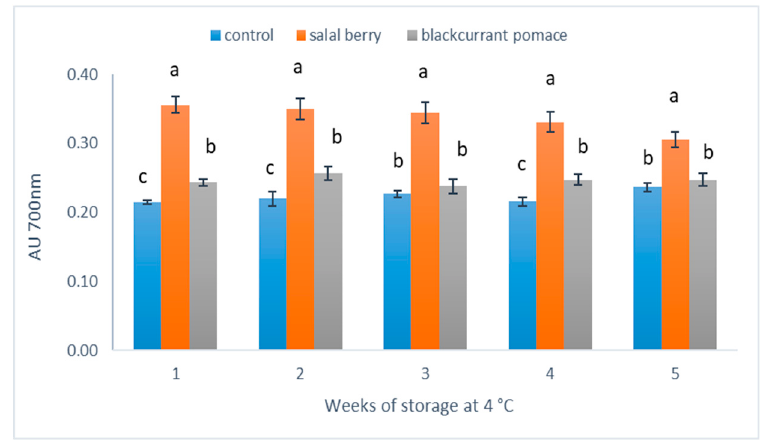
Figure 5. Reducing power of different yogurt beverages. Results are presented as means ± SD. Different low case letters denote significant differences at each time point ( p < 0.05).